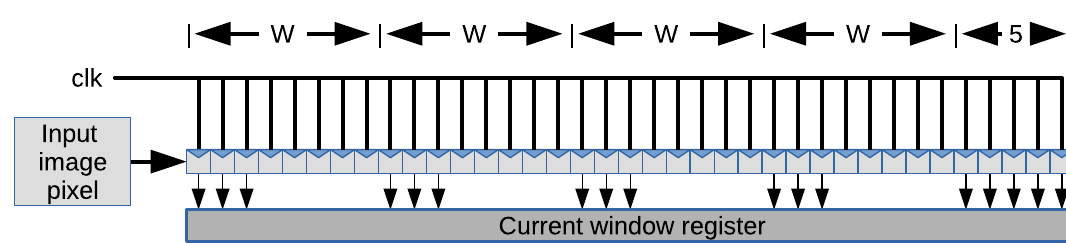
Figure 3. Block diagram of the shift register used for image